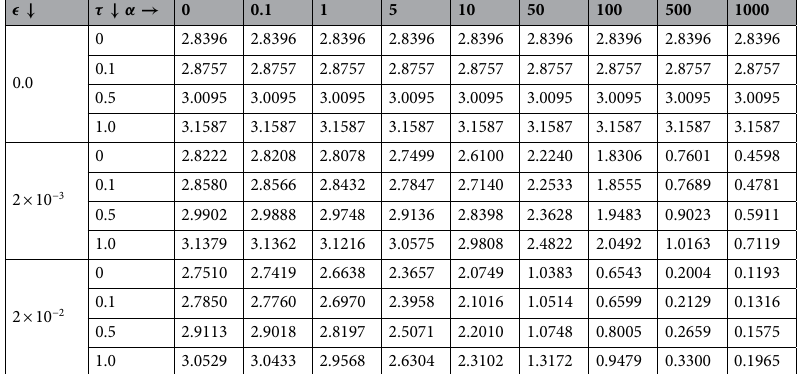
Table 2. Floating ion velocity U f (α , τ , ǫ) .